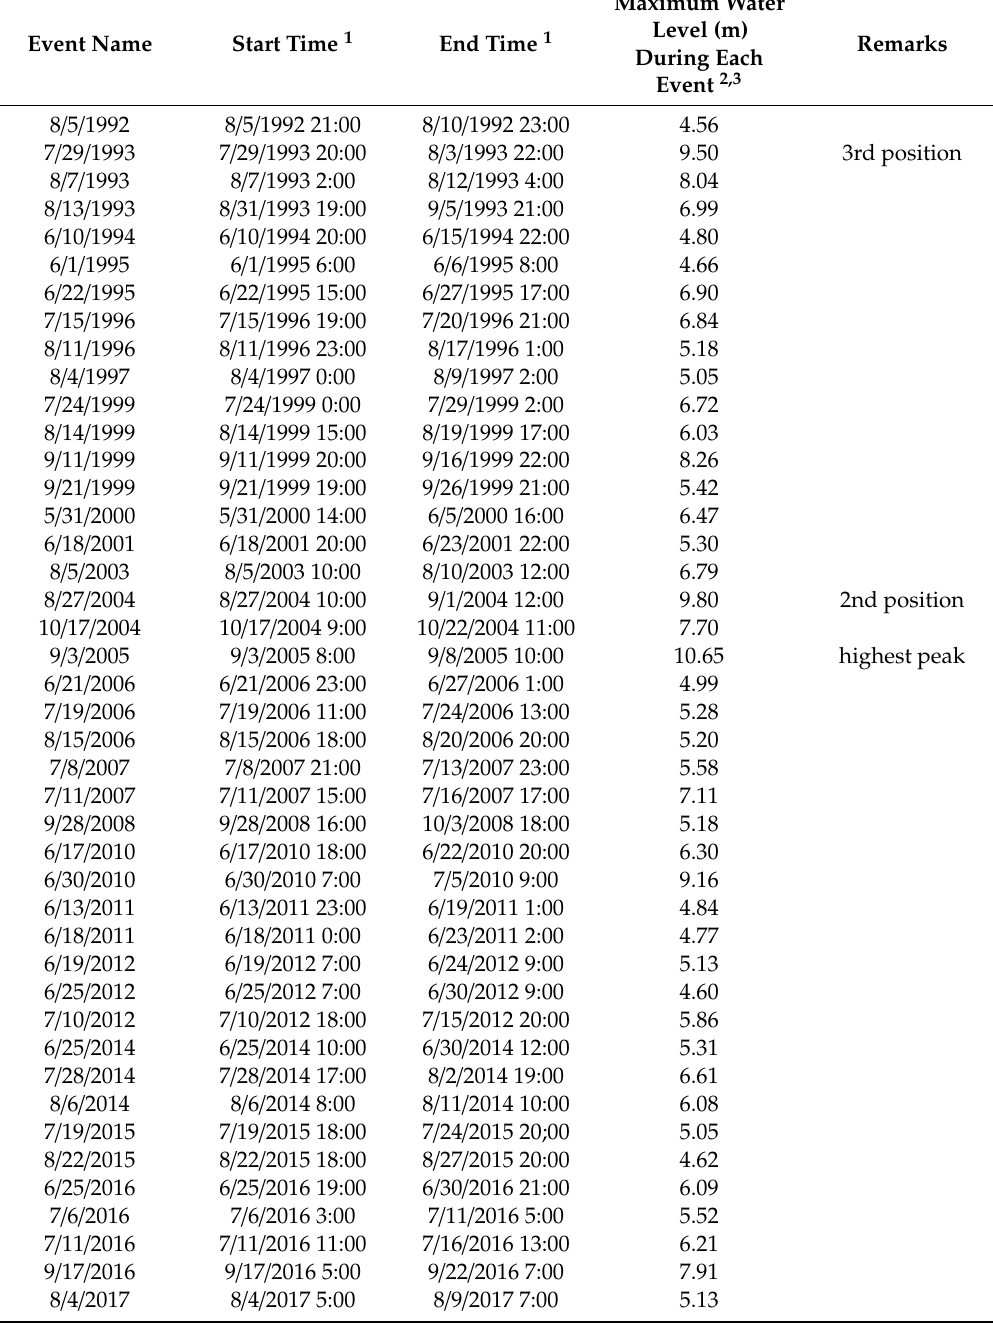
Table 1. Flood events in Domain